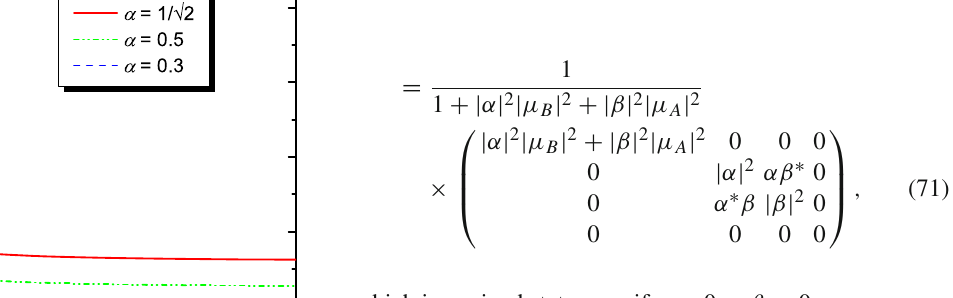
Fig. 9 The concurrence of the final state of two entangled qubits as a function of the volume ε and the rapidity σ of the cosmic expansion. The parameters of the two qubits are the same. The qubit energy level difference is (cid:15) = 2, the inner product of the mode functions, defined in Eq. (21), is μ = 0 . 1, the mass of the scalar field particle is m = 0 . 01. ( | 01 (cid:7) + | 10 (cid:7) The initial state of the two qubits is 1 √ 2